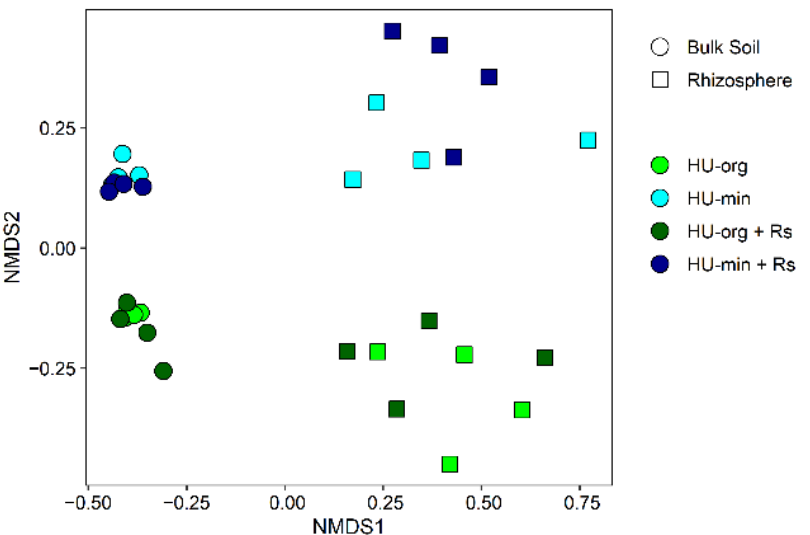
Figure 3. Non-metric multidimensional scaling (NMDS) of bacterial communities in bulk soil and rhizosphere (stress = 0.10) of lettuce (cv. Tizian) depending on long-term fertilization strategy (HU- org—organic fertilization; HU-min—mineral fertilization) and the presence of Rhizoctonia solani AG1-IB